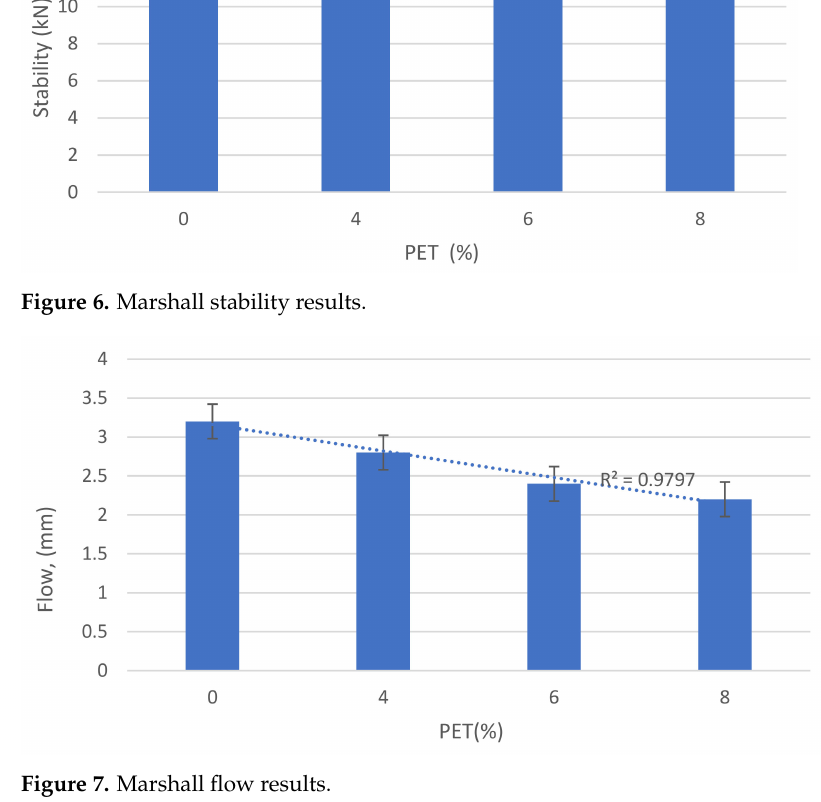
Figure 7. Marshall flow results.